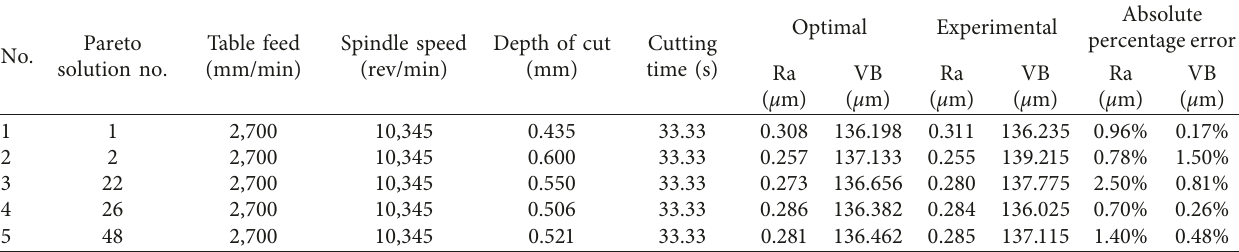
Table 11: Validation of predicted